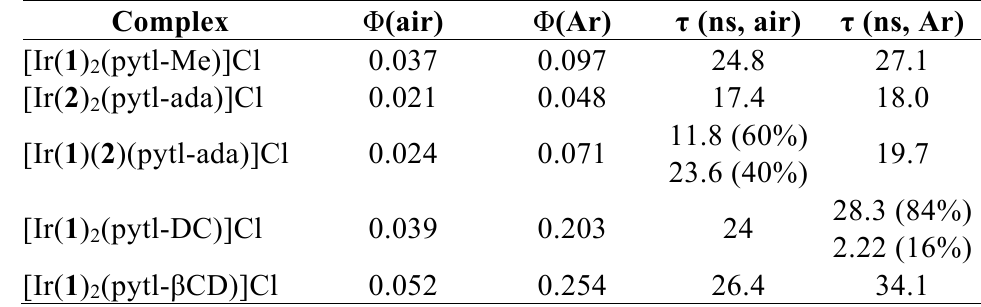
Table 1. Luminescence lifetimes and quantum yields of emission of the complexes. For = 335 nm. For lifetime measurements λ = 324 nm. The quantum yield measurements λ exc exc solutions were measured in air equilibrated acetonitrile (air) and argon saturated (Ar) for degassing by bubbling argon for 20-30 minutes through the